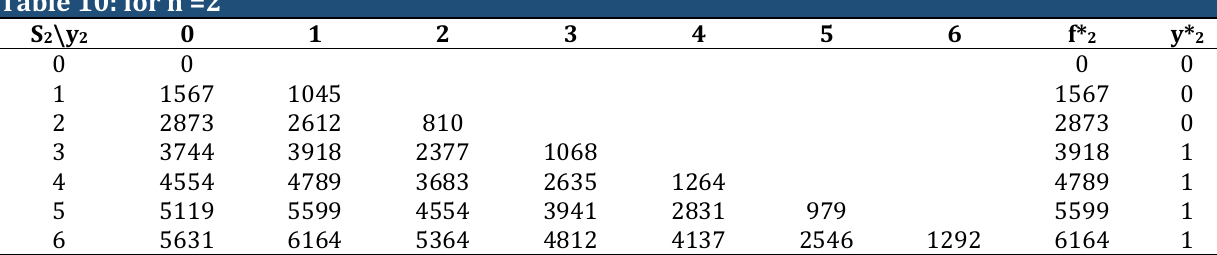
Table 10: for n =2